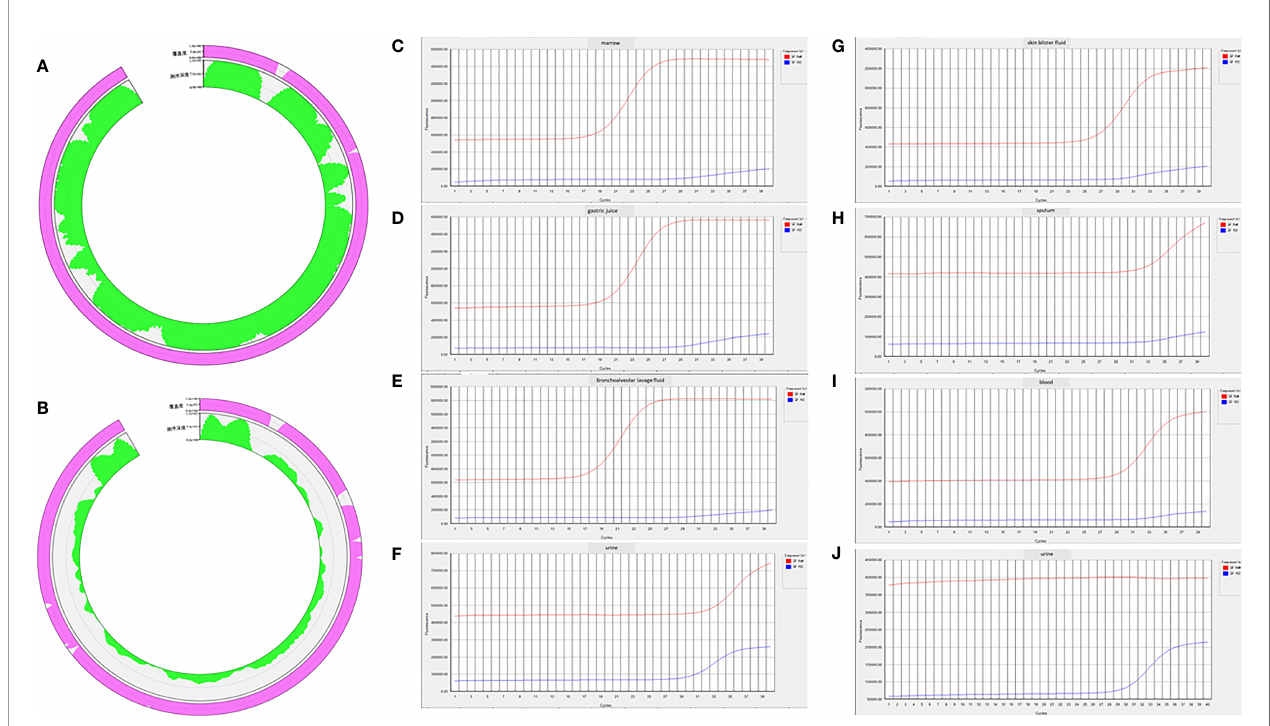
FIGURE 4 | (A) Next-generation sequencing (NGS) results of blood collected at 8 h after the patient was transferred to the medical intensive care unit (MICU) reported extremely high DNA copies of B19 (1,605,726 copies/µg DNA, and the relative abundance was 99.99%). (B) NGS results of bronchoalveolar lavage fl uid (BALF) collected on the third day in MICU reported high DNA copies of B19 (15,938 copies/µg DNA, and the relative abundance was 97.85%). (C – F) Real-time PCR con fi rmed positive results of B19 in bone marrow, gastric juice, BALF, and urine collected on the eighth day in MICU. (G – J) Real-time PCR con fi rmed positive results of B19 in skin blister fl uid, sputum, and blood collected on the eighth day in MICU. (J) Real-time PCR showed that the previously positive result of B19 in urine became negative in the urine sample collected on the tenth day in